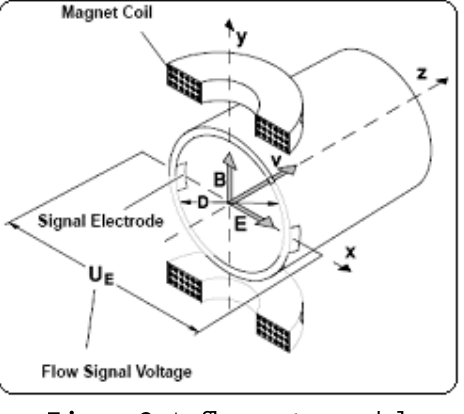
Figure 2. A flowmeter